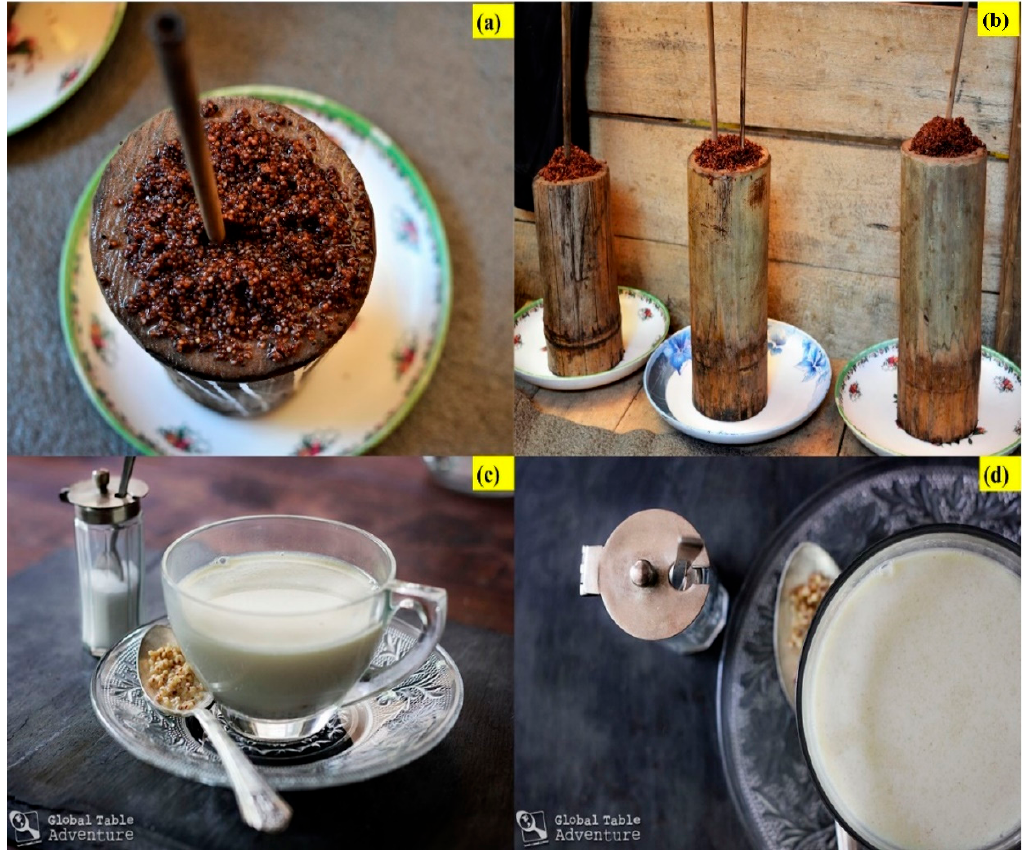
Figure 6. ( a , b ) Tongba—a fermented beer produced from millet in Sikkim (an eastern Himalayan and northeastern state of India) (Picture: Saurav Das). ( c , d ) Suutei Tsai—A Mongolian Tea made from millet (Picture credit: Global Table Adventure: http://globaltableadventure.com/recipe/mongolian- millet-green-milk-tea-suutei-tsai/).